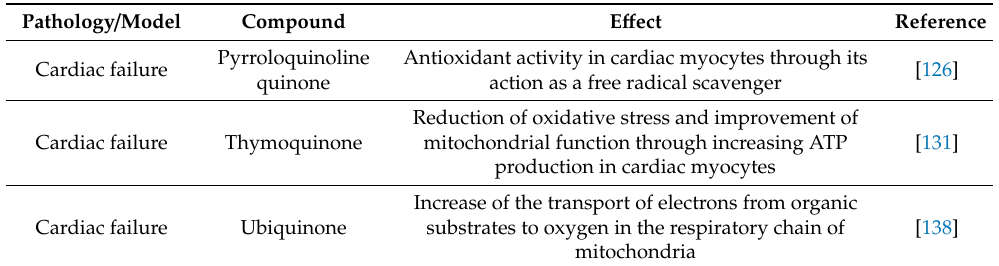
Table 2. The most common and studied quinones compounds that provide mitochondrial